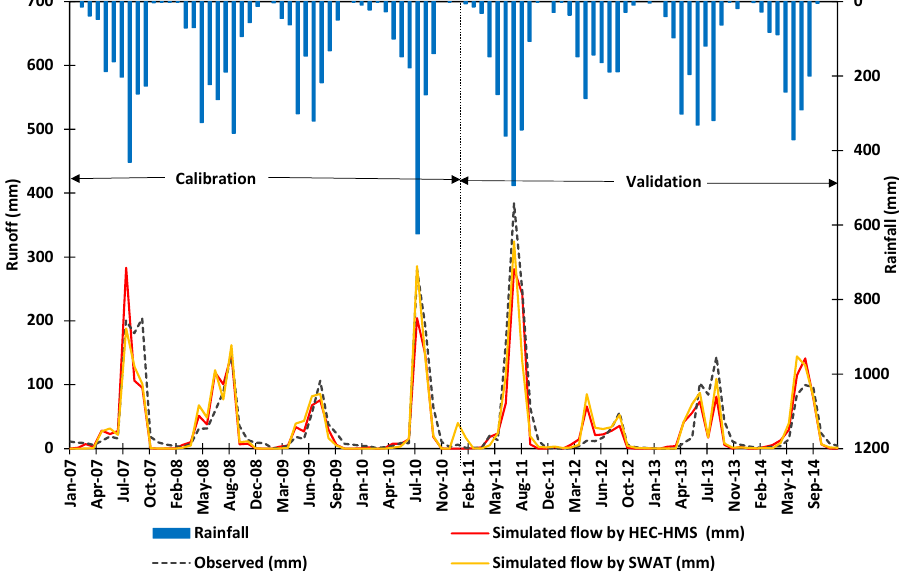
Figure 5. Comparison of observed and simulated hydrographs for the HEC-HMS and SWAT models for the period 2007–2014 of the HBS watershed.